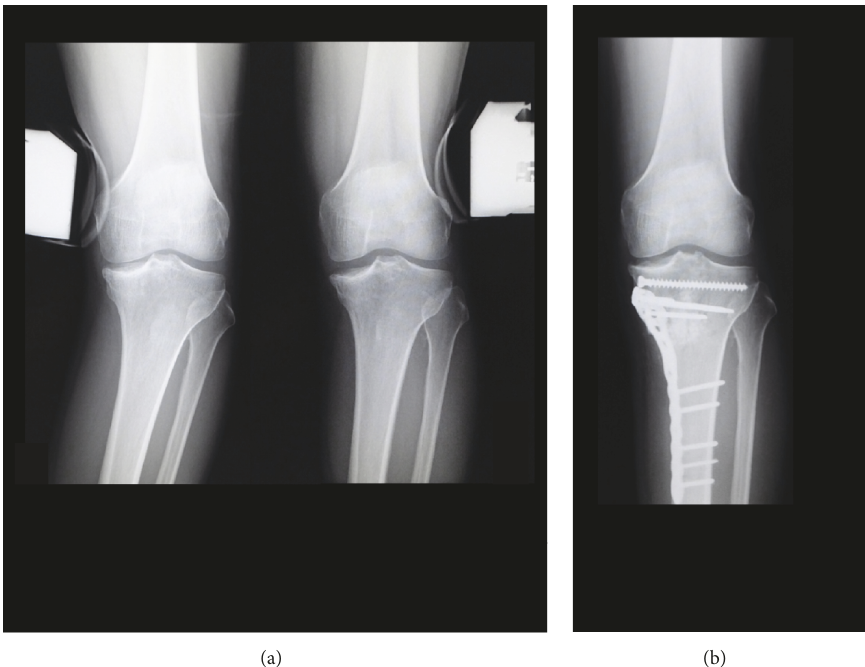
Figure 6: (a) Teeter effect due to intra-articular deformity after medial tibial plateau fracture. (b) After reconstruction by tibial condylar valgus osteotomy (TCVO).